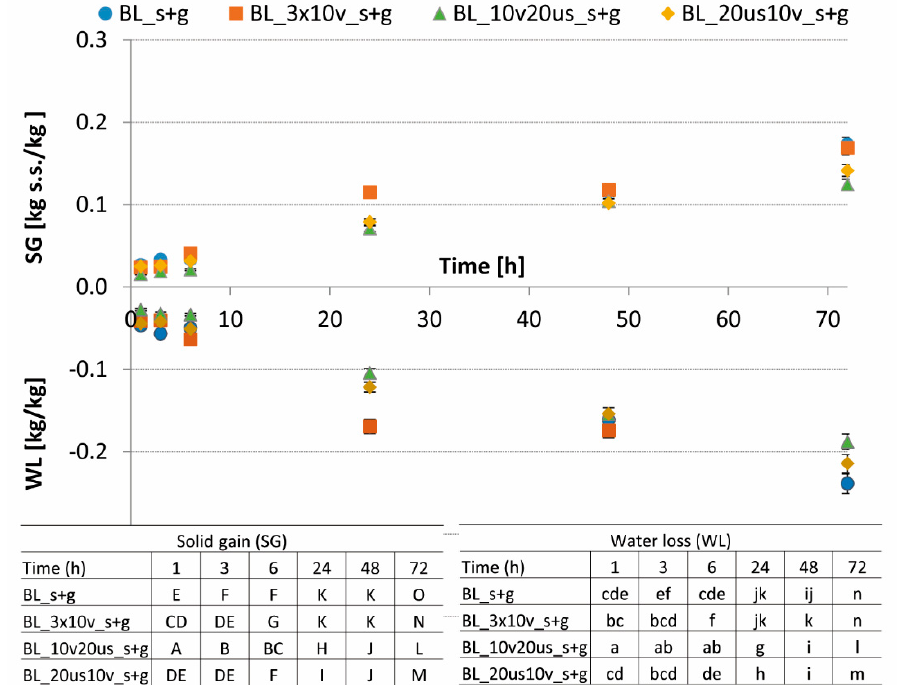
Figure 2. Water loss (WL) and solid gain (SG) as a function of the osmotic dehydration time of di ff erent treated cranberries in 30% sucrose solution with 0.1% addition of steviol glycosides. Di ff erent letter means significant di ff erence by the Duncan test ( p < 0.05).